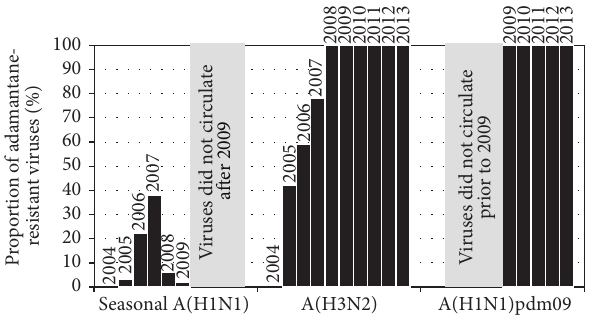
Figure 1: Frequency of adamantane-resistant viruses circulating in the